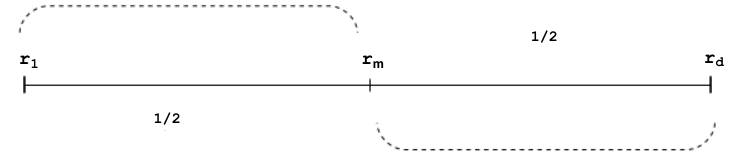
Figure 3. In a path anatomy the sequence of routers that form the path can be partitioned into two sub-paths which have equal length. Recovery can be achieved by either reconfiguring the flow tables associated with the half of the path which contains the failure, or the link which has